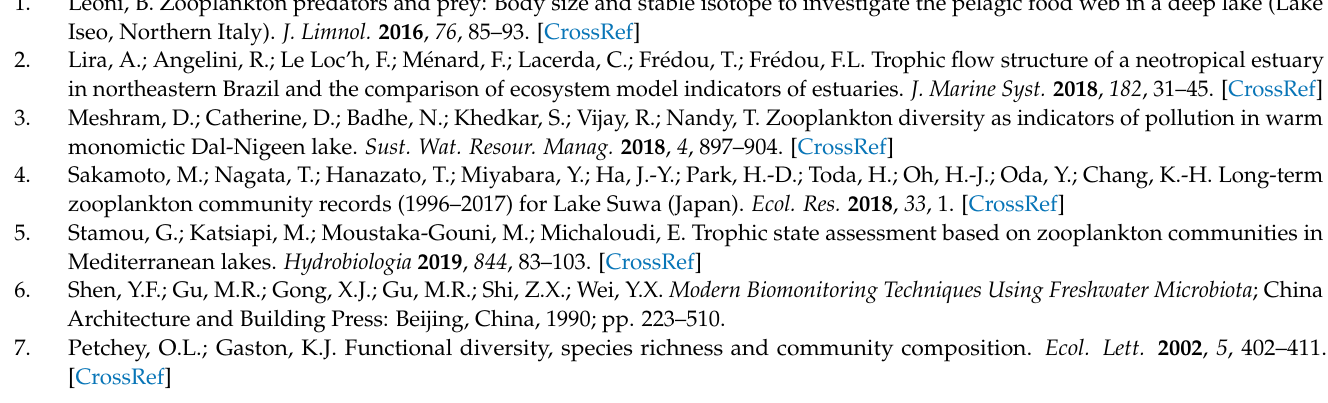
based on ZFGs; Table S1: Functional groups of zooplankton; Table S2: Spatiotemporal variations of physicochemical parameters; Table S3: Species compositions of zooplankton detected in this study; Table S4: Compositions of zooplankton functional groups in Chaohu Lake Basin; Table S5. Pearson correlation coefficients between zooplankton functional groups and environment